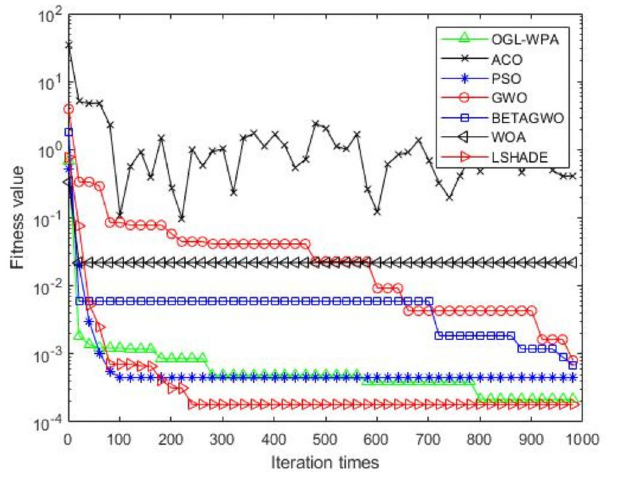
Fig 3. F2 iteration